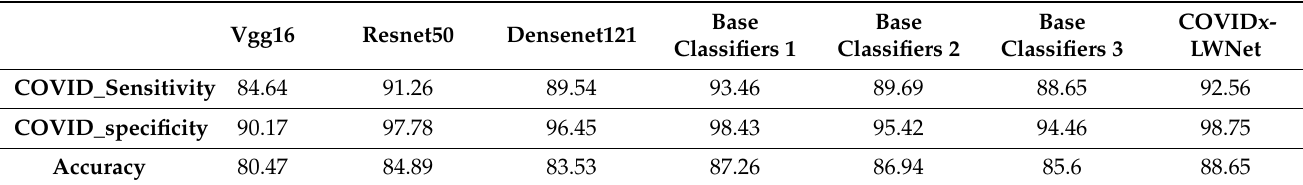
Table 12. D3_2:D2 (train: test),